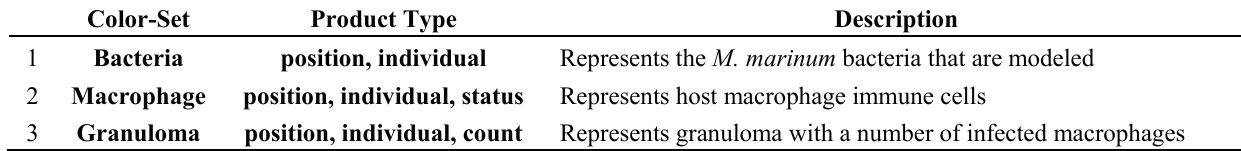
Table 2. Compound color-sets defined for the colored Petri net